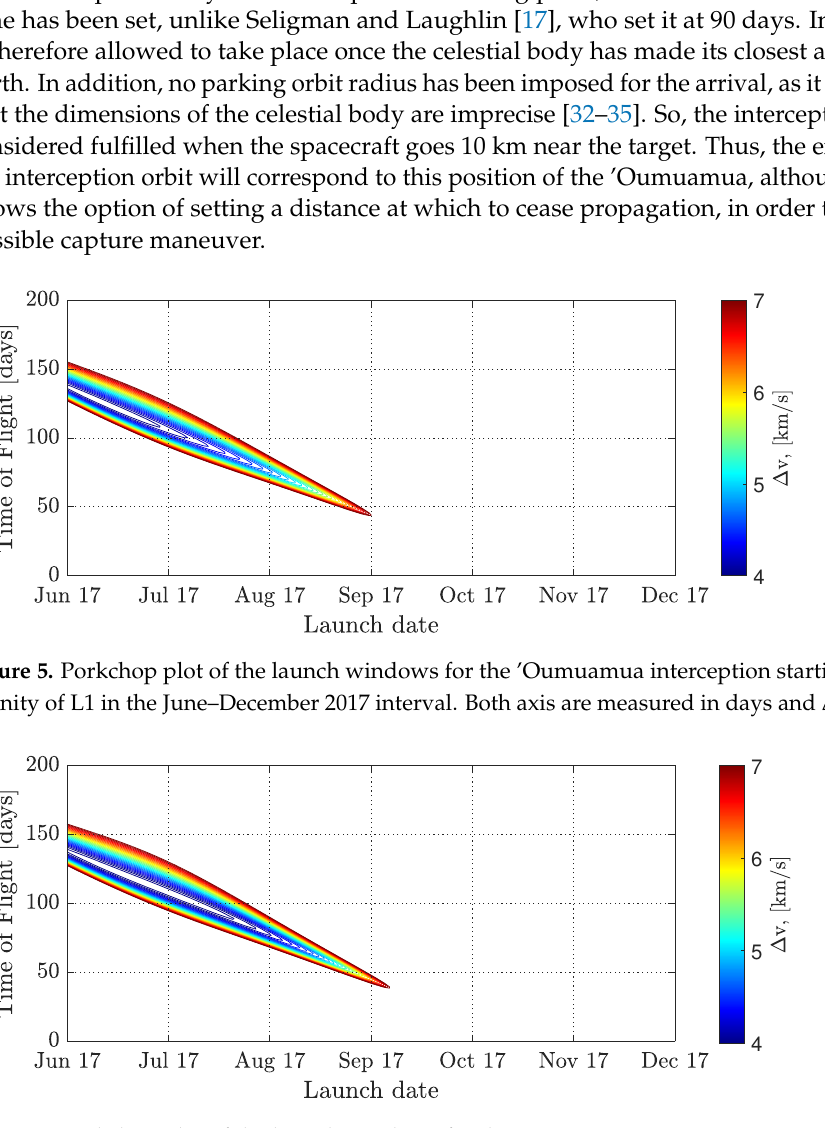
Figure 6. Porkchop plot of the launch windows for the ’Oumuamua interception starting from the vicinity of L2 in the June–December 2017 interval. Both axes are measured in days and ∆ v in